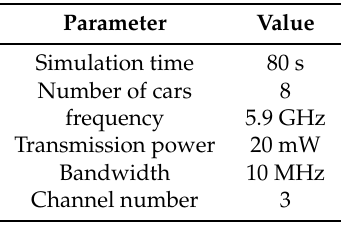
Table 6. OMNET++ configuration.